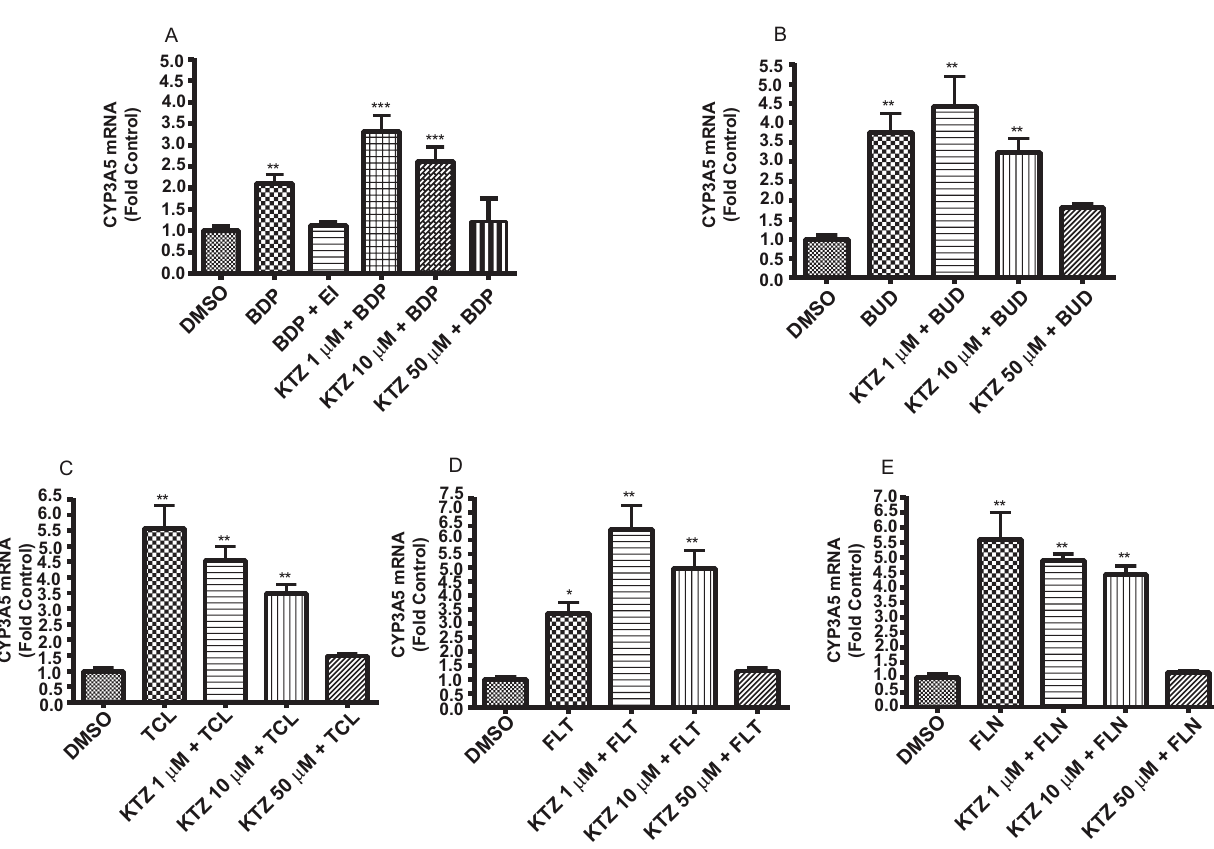
Figure 4. Ketoconazole inhibits the induction of CYP3A5 through the glucocorticoid receptor (GR). CYP3A5 mRNA detected in A549 cells treated with ( A ) beclomethasone dipropionate (BDP), ( B ) budesonide (BUD), ( C ) triamcinolone acetonide (TCL), ( D ) fluticasone propionate (FLT), and ( E ) flunisolide (FLN), with and without ketoconazole (KTZ), a competitive antagonist for GR. Results are presented as fold over DMSO controls. Statistics used for data analysis were one-way ANOVA with Dunnett’s post-hoc test. Data are the mean and standard deviation from n=6 replicates. * p<0.05, ** p<0.01, ***